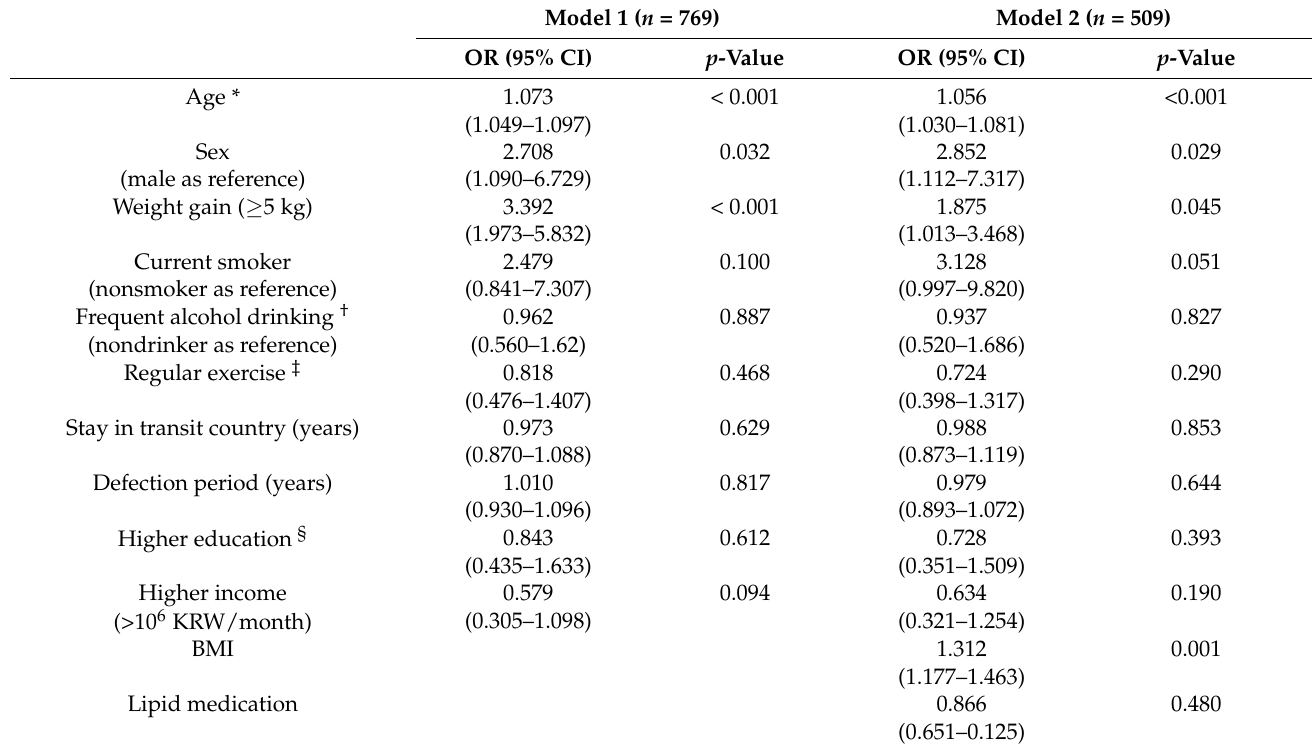
Table 4. Odds ratio of metabolic syndrome risk among North Korean